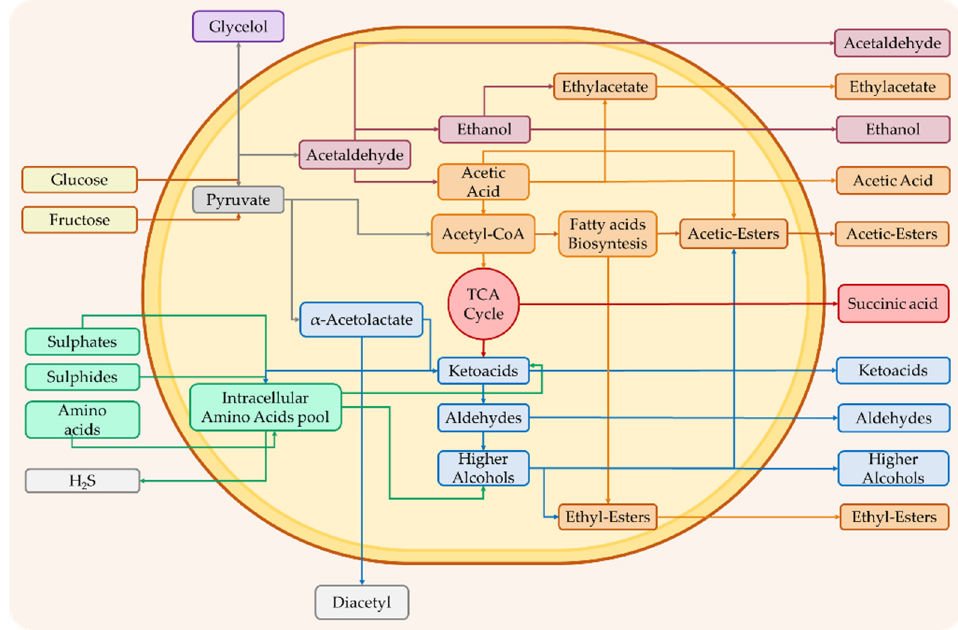
Figure 2. Representation of the main biochemical pathways that lead to the formation of compounds deriving from primary and secondary metabolism in yeast able to affect the aroma of wine.